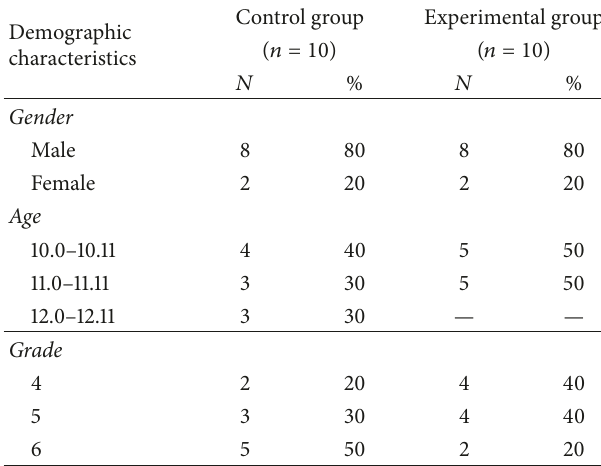
Table 4: Demographic variables of the control and experimental